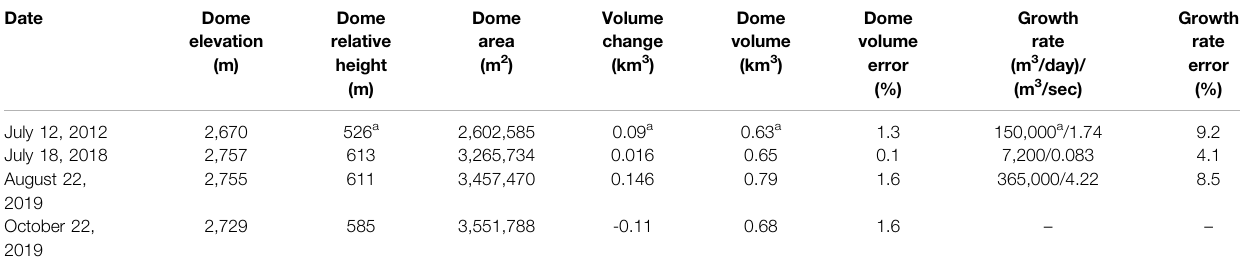
TABLE 1 | Main geometric parameters summarizing the initial construction and later destruction of the Shiveluch